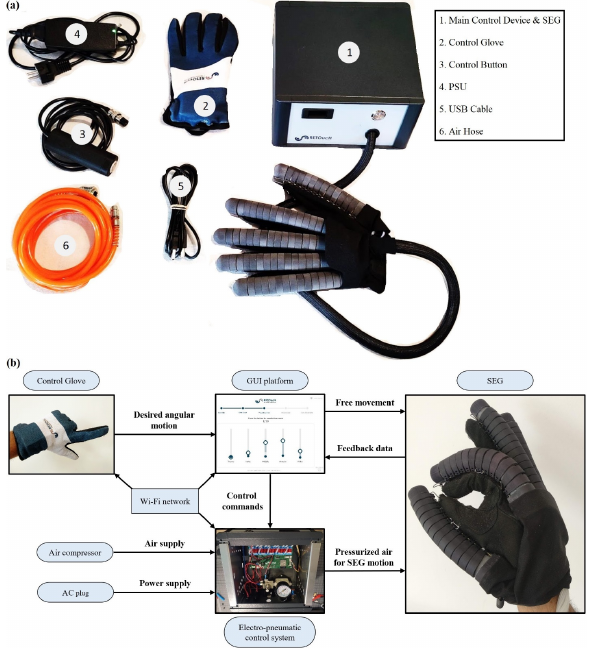
11 of 20 Figure 7. ( a ) Initial window with session information; ( b ) Main window of GUI application. 3. Results and Discussion 3.1. Final Design of the SEG Device In this sub-section, the final design of the overall SEG device is presented, coupled with its components and main technical characteristics. In detail, as is depicted in Figure